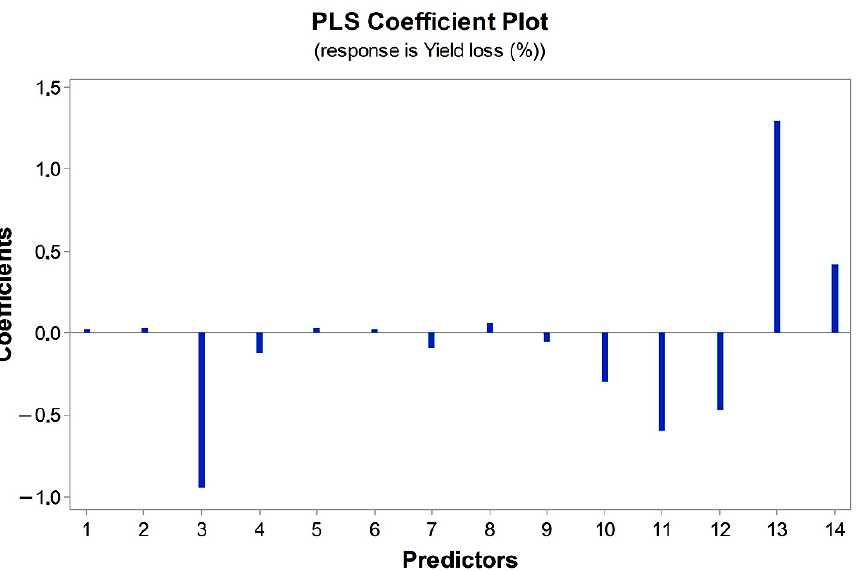
Figure 2. Partial least square coefficient plot of climatic factors influencing yield loss of variety